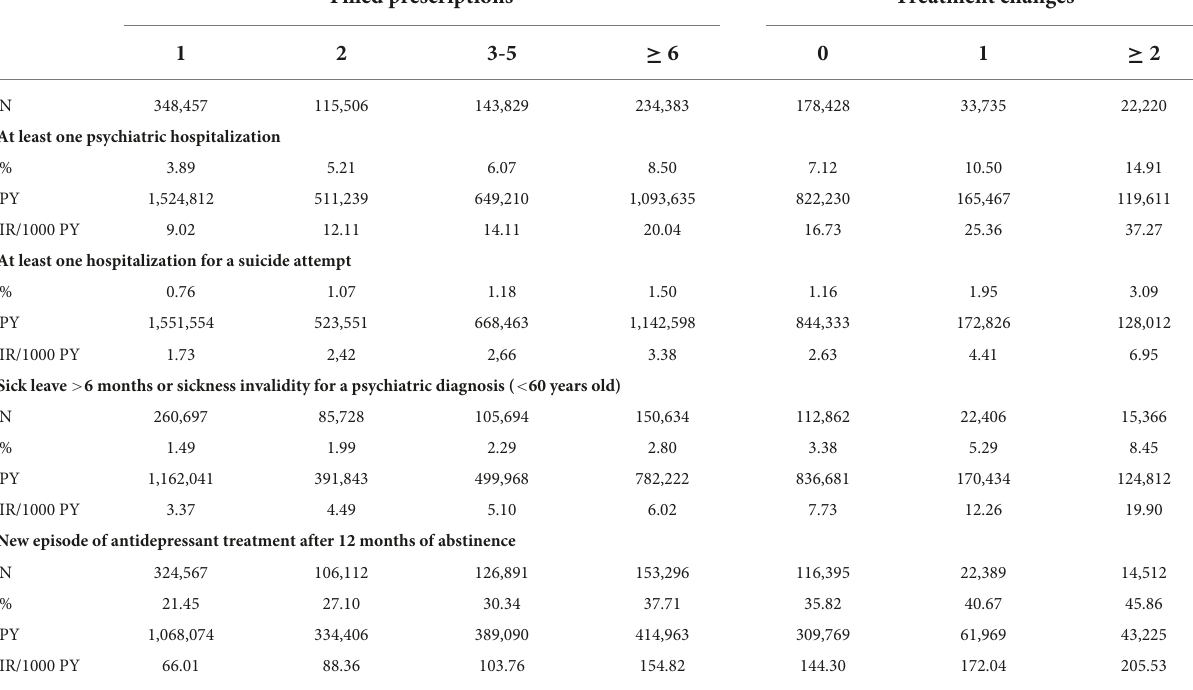
TABLE 2 Crude incident rate for each long-term psychiatric outcome according to the number of filled antidepressant prescriptions and treatment changes. Filled prescriptions Treatment